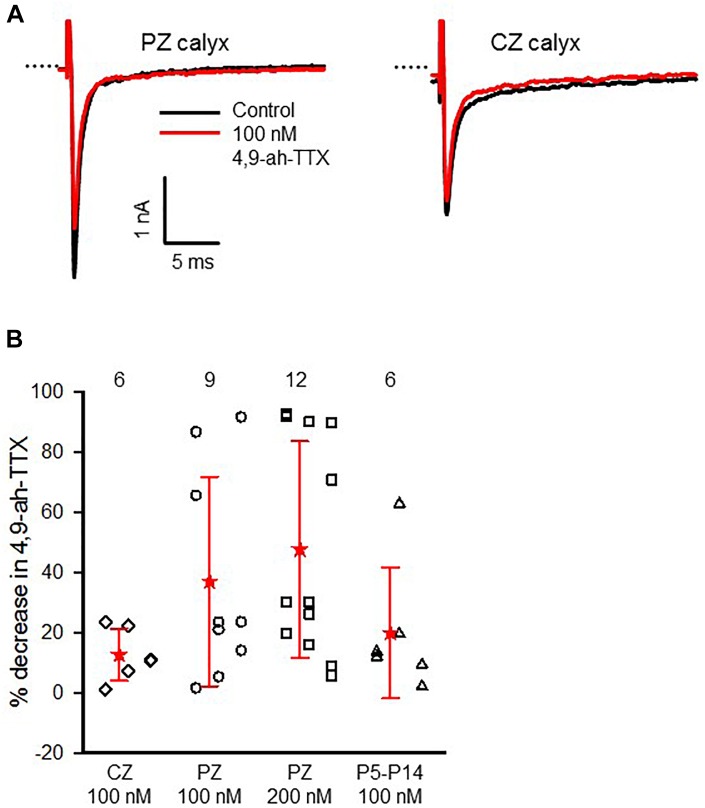
Effect of 4,9-an-TTX on INa is greatest in mature PZ calyces. (A) Reduction of INa in response to perfusion of 100 nM 4,9-ah-TTX in a representative PZ calyx (P31) and CZ calyx-only fiber (P27) in crista slice in response to a voltage step from –130 to –50 mV. External solution was 0 K+ HEPES. (B) Mean response to 100 nM 4,9-ah-TTX in mature CZ (; P20–27), PZ (o; P22–31) and immature calyces (Δ; P5–14) and response in mature PZ calyces (; P22–29) to 200 nM 4,9-ah-TTX are shown. Numbers above plots indicate number of cells for each group. Electrode solution was Cs+-based and external solution was L-15 or 0 K+ HEPES with either 80 mM Na+ or 150 mM Na+.